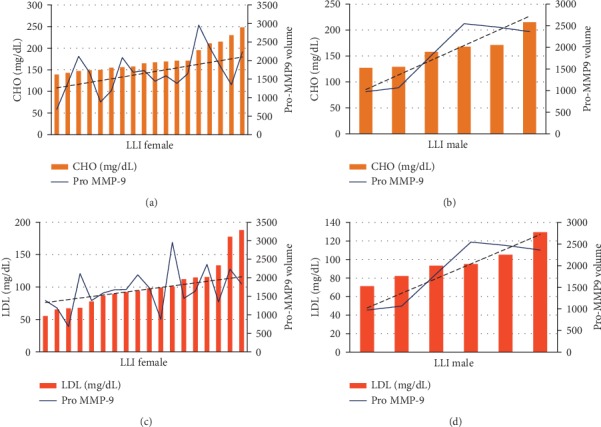
Histograms of Pro-MMP-9 activity levels and hematological values of CHO in the female (a) and male (b) LLI group and of LDL in the female (c) and male (d) LLI group.